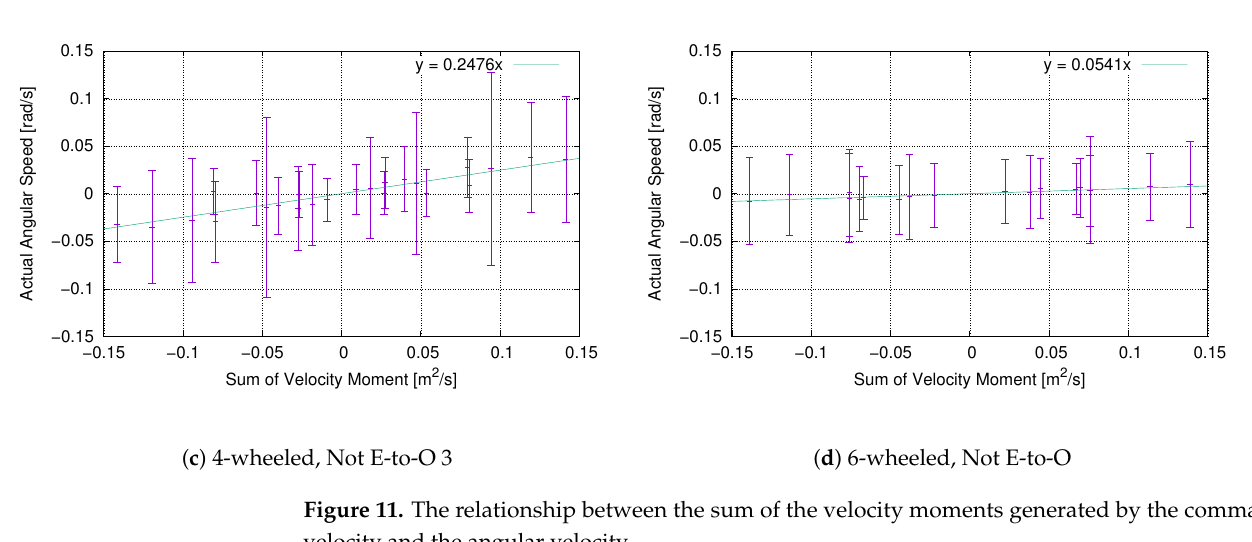
Figure 11. The relationship between the sum of the velocity moments generated by the command velocity and the angular